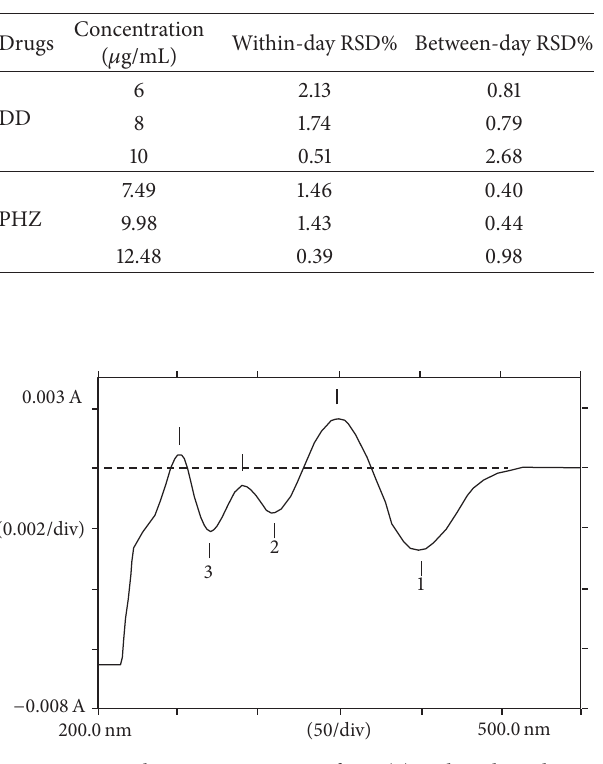
Figure 4: First derivative spectrum of DD (1) and its degradation products (2, 3) in acidic conditions.